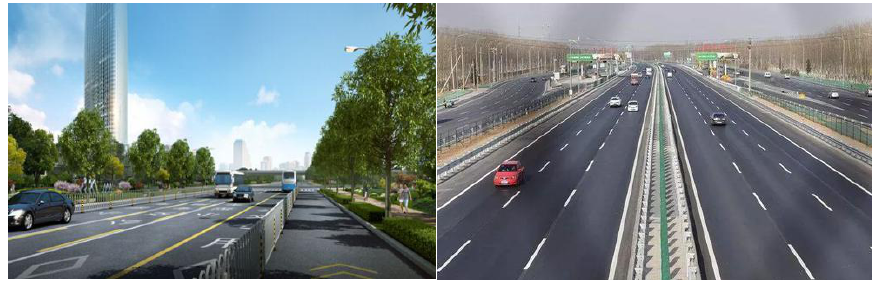
Figure 1. Surface traffic scene.